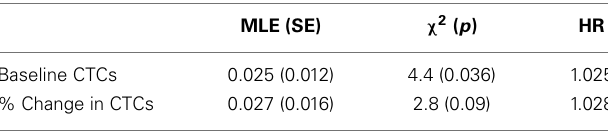
Table 4 | Maximum likelihood estimates (standard errors) and hazard ratios from cox proportional hazards regression model including the predictors baseline CTCs and % change from baseline to post-treatment